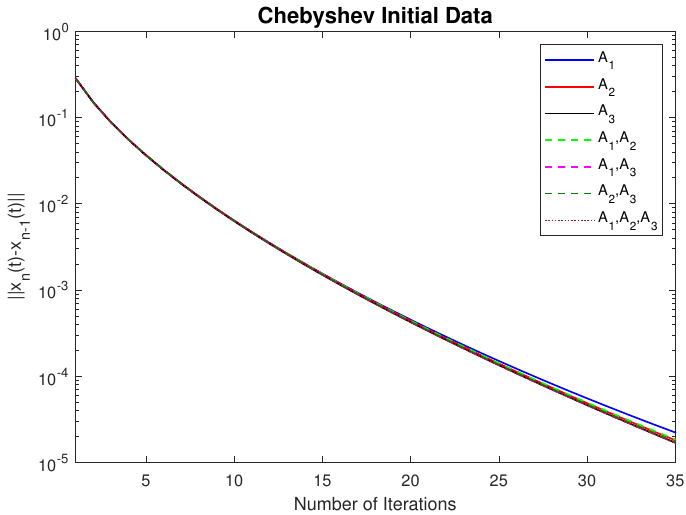
Figure 5. The error plotting (cid:107) x n ( t ) − x n − 1 ( t ) (cid:107) for choice 2 in Example